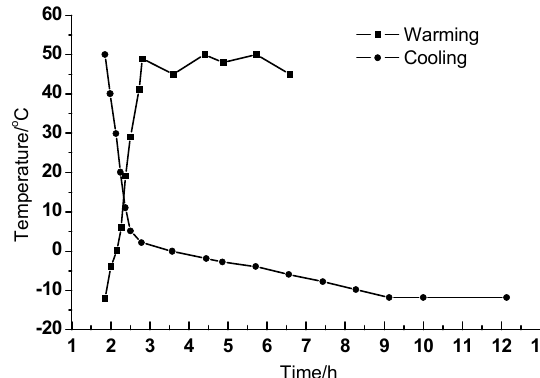
Figure 3. The temperature curve during fatigue testing.